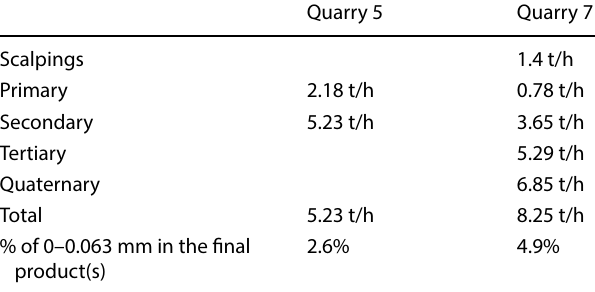
Table 4 0–0.063 mm fraction in the quarry 5 and 7